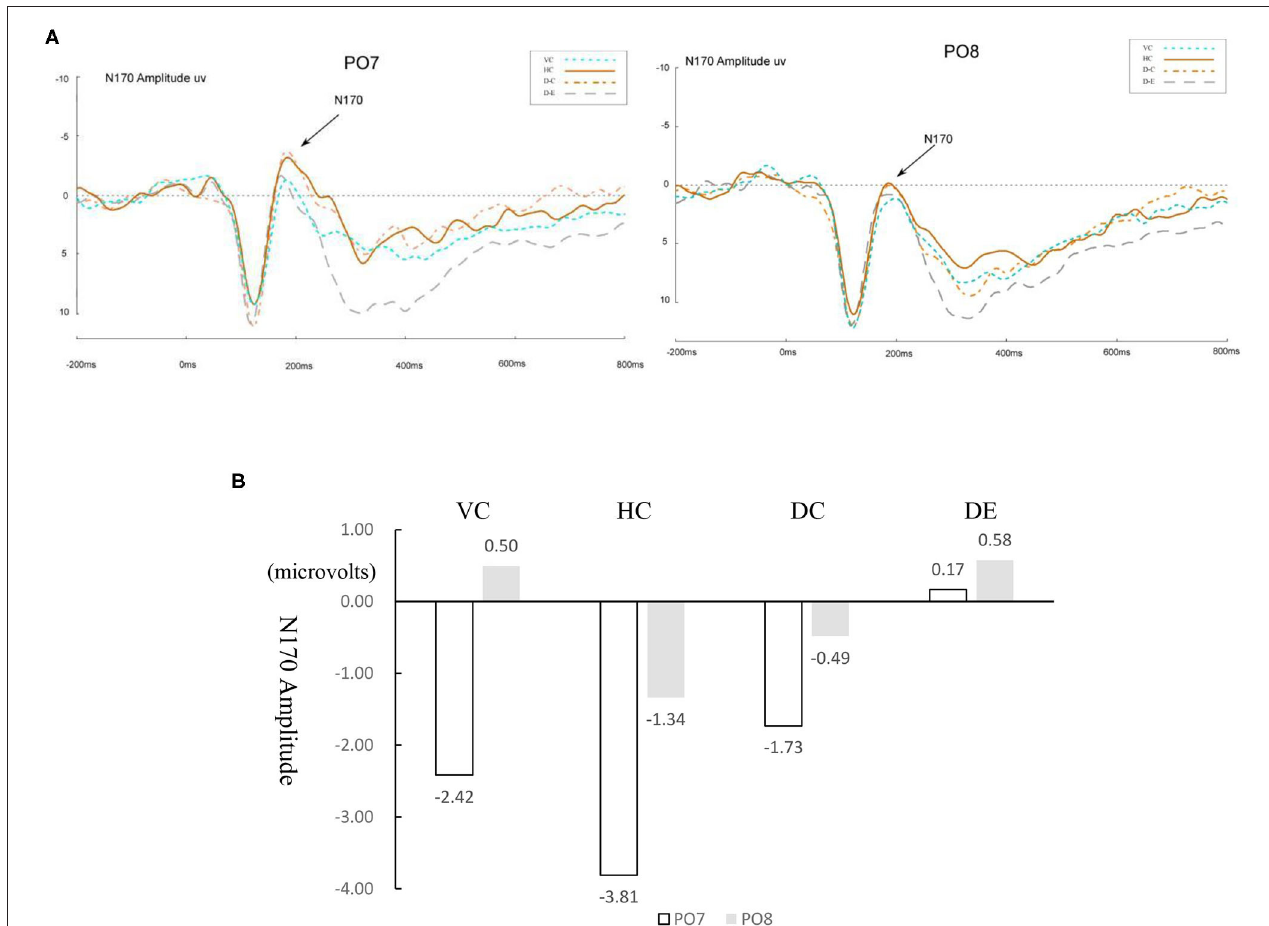
FIGURE 3 | (A) ERP waveforms of the N170 under four conditions for normal readers for the left (PO7) and right (PO8) parietal leads. VC, viewing-Chinese; HC, handwriting-Chinese; DC, drawing followed by Chinese recognition; DE, drawing followed by English recognition. (B) Differences between four conditions for normal readers in the amplitude of